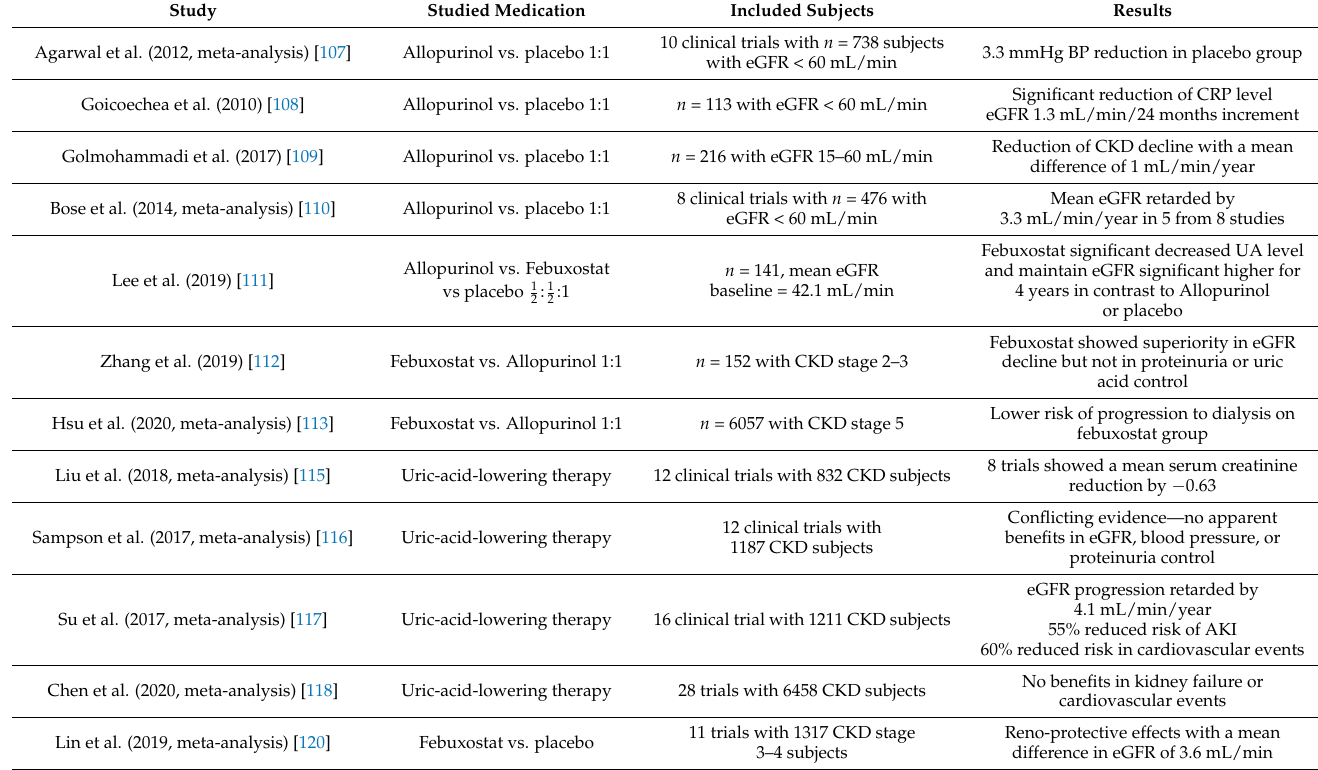
Table 1. Interventional studies focused on uric-acid-lowering treatment in CKD patients with